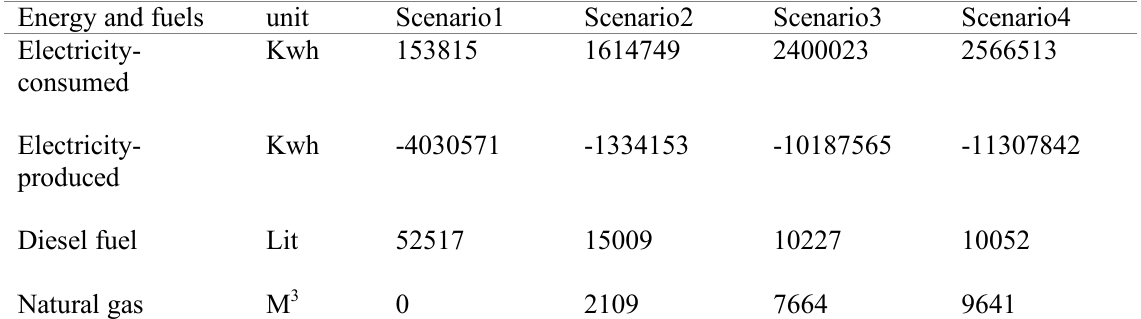
Table 3 . Energy consumed in different scenarios per functional unit (annual waste tonnage)